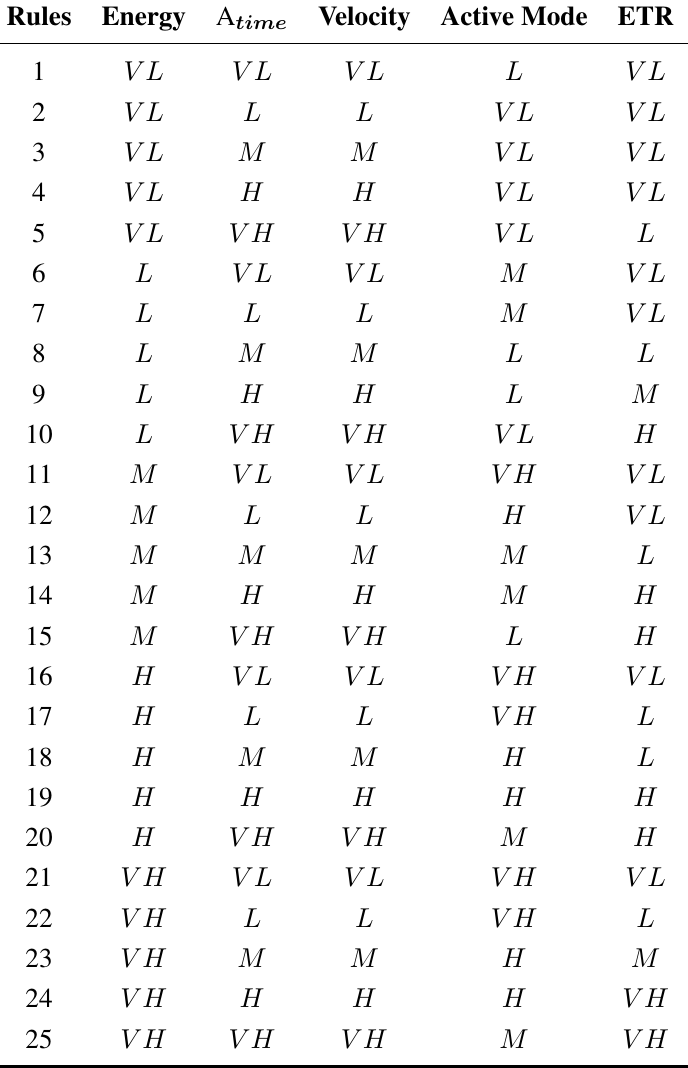
Table 1. Inference rules for active and extended transmission range (ETR) node